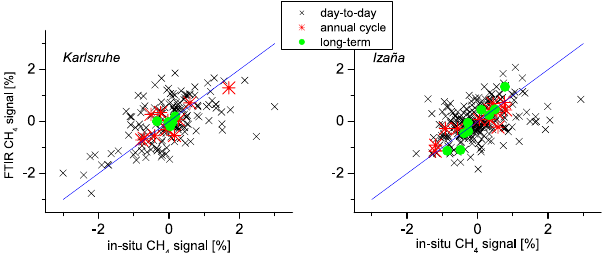
Figure 10. NDACC FTIR/GAW correlation plots for CH 4 varia- tions/signals on different timescales. Left graph: for Karlsruhe; right graph: for Izaña. The day-to-day variation is shown as black crosses, the monthly variation (annual/seasonal cycle) as red stars, and the long-term variation as green circles.